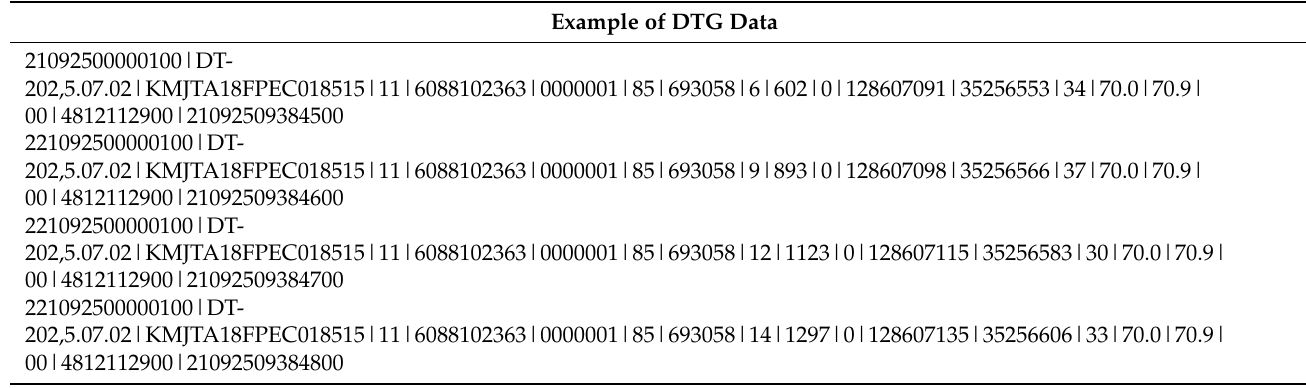
Table 4. Example of DTG data.